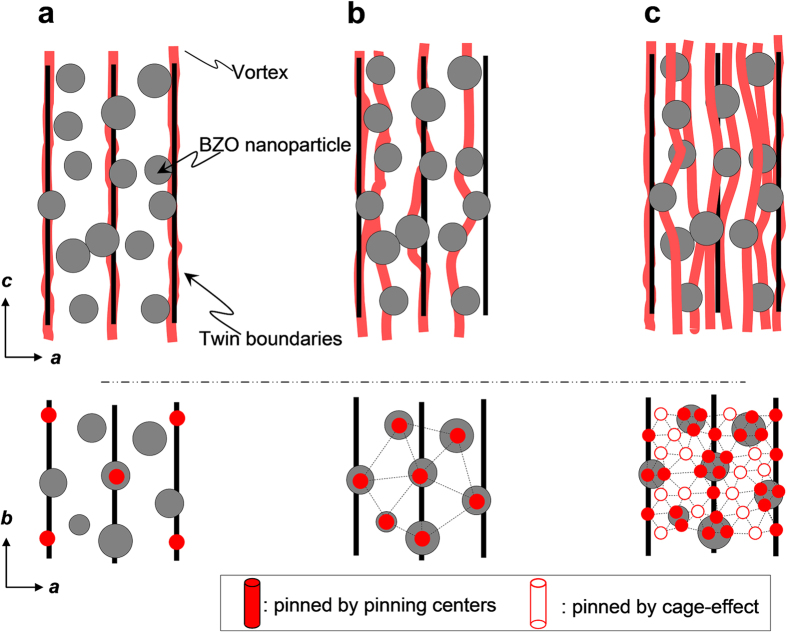
Diagrams of vortex pinning for configurations involving different defects at H||c.(a) Diagram of vortex and c-axis parallel correlated TBs and BZO NPs at μ0H<μ0Hϕ,TB. (b) Diagram of a vortex and BZO NPs and TBs at μ0H ∼ μ0HBZO(af = dBZO), showing that above μ0Hϕ,TB vortices are localized not only by TBs but also by BZO NPs. (c) Diagram of a vortex and hybrid defects at μ0H ≫ μ0HBZO, showing how a large number of vortices are arrested by BZO NPs and TBs.